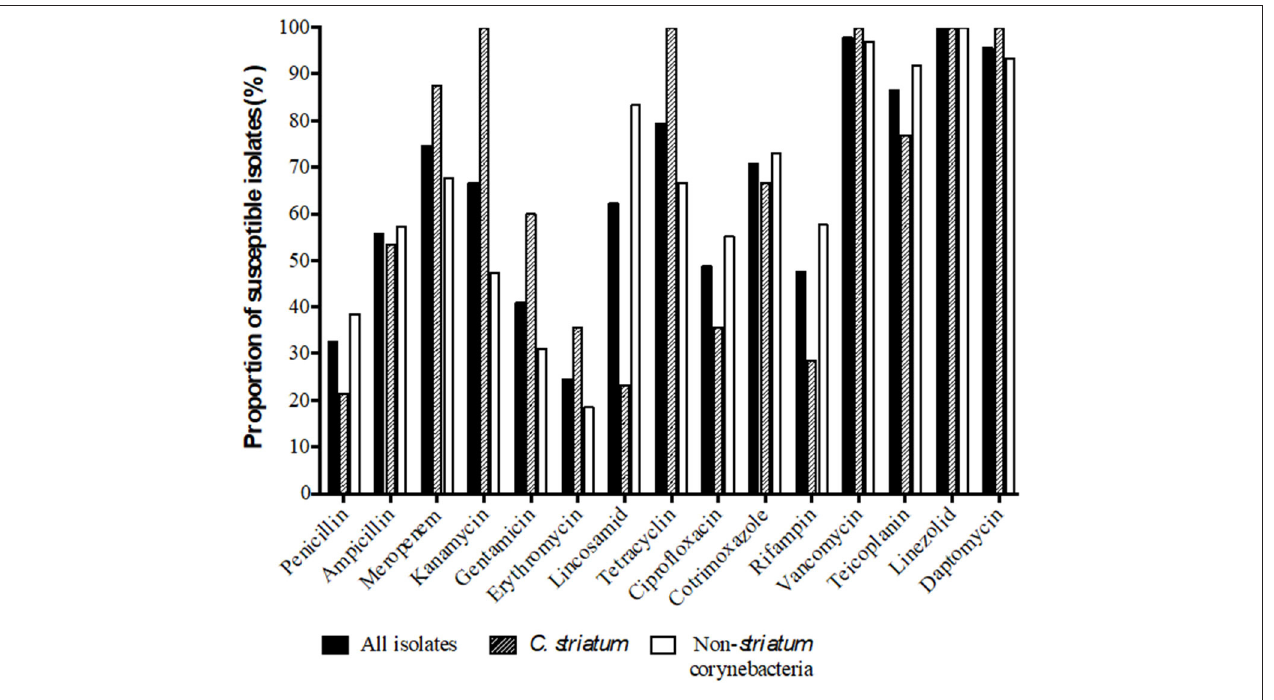
FIGURE 1 | Susceptibility profile of the 51 BJI Corynebacterium spp.